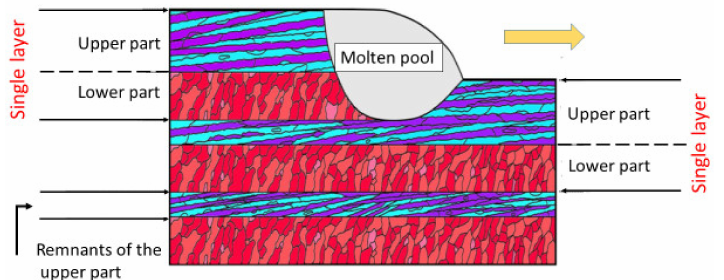
Figure 11. Mechanism of formation of the two types of columnar grains during WAAM of 7055. Redrawn from ref. [136] (reproduced with permission from Additive Manufacturing; published by Elsevier,